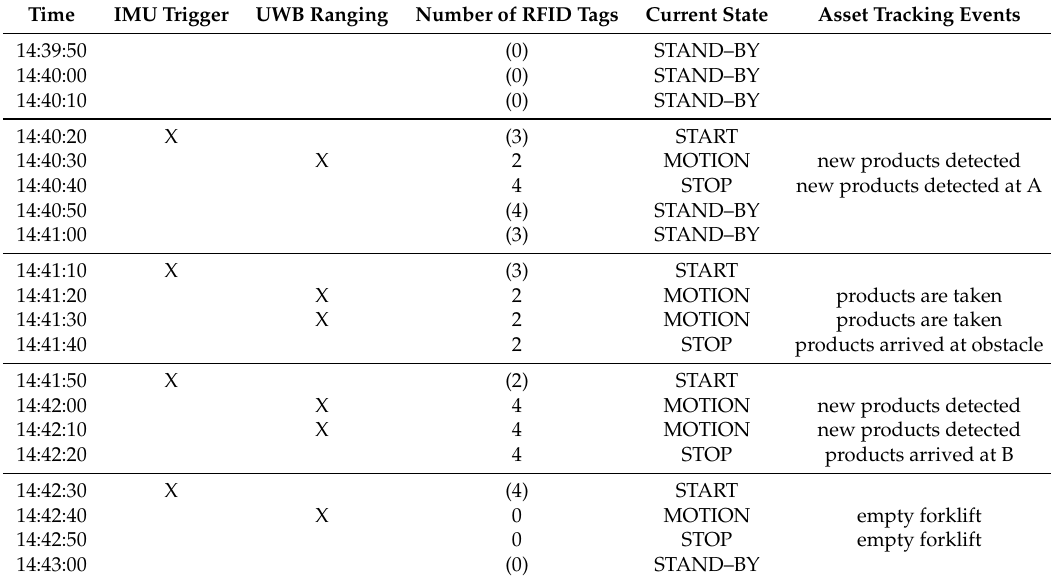
the five phases: the last column of Table 2 indicates that valid events happened at the two workstations, while the stop at the obstacle is irrelevant. Table 2. Summary of the Use-Case Scenario: IMU Triggers UWB Ranging, the RFID Reader Identifies the Assets in Sight (Numbers in Brackets Mark Measurements, That Ore Not Part of the Identification Scheme). Current State Stands for the Mode the System Operates in at the Moment, Asset Tracking Events Describe The Outcome of the